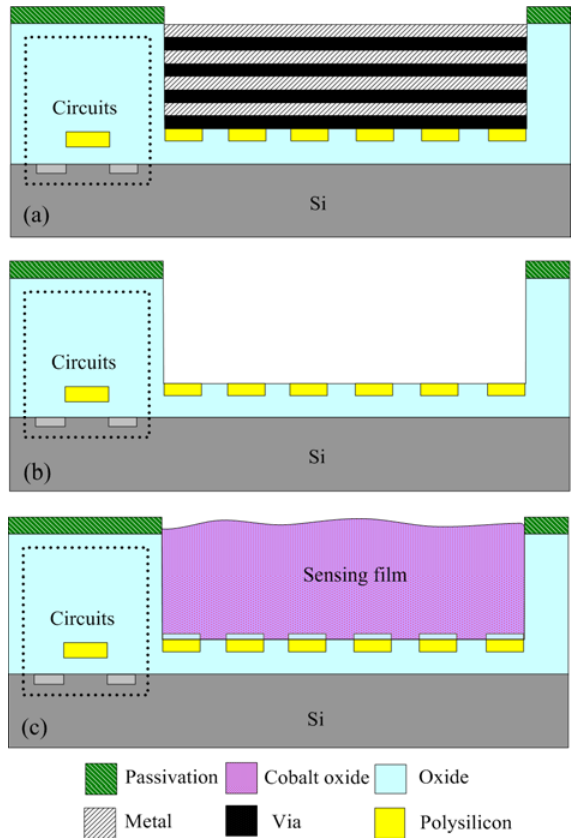
Figure 8. Fabrication process of the CO sensor: (a) after the CMOS process, (b) etching the sacrificial layer, (c) coating the sensing film.